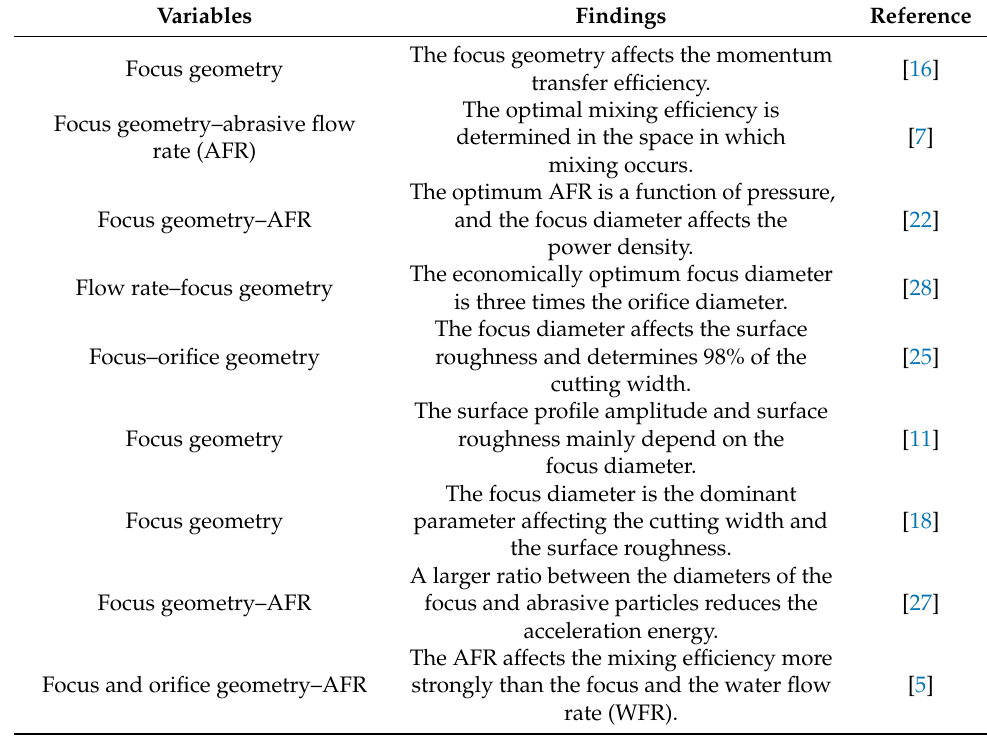
Table 1. Previous studies of the effects of the mixing variables on an abrasive